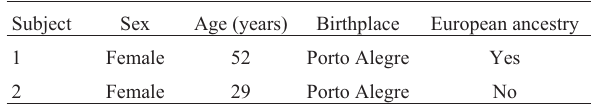
Table 2 - Characteristics of individuals heterozygous for variant c.1528G>C ( HADHA ).